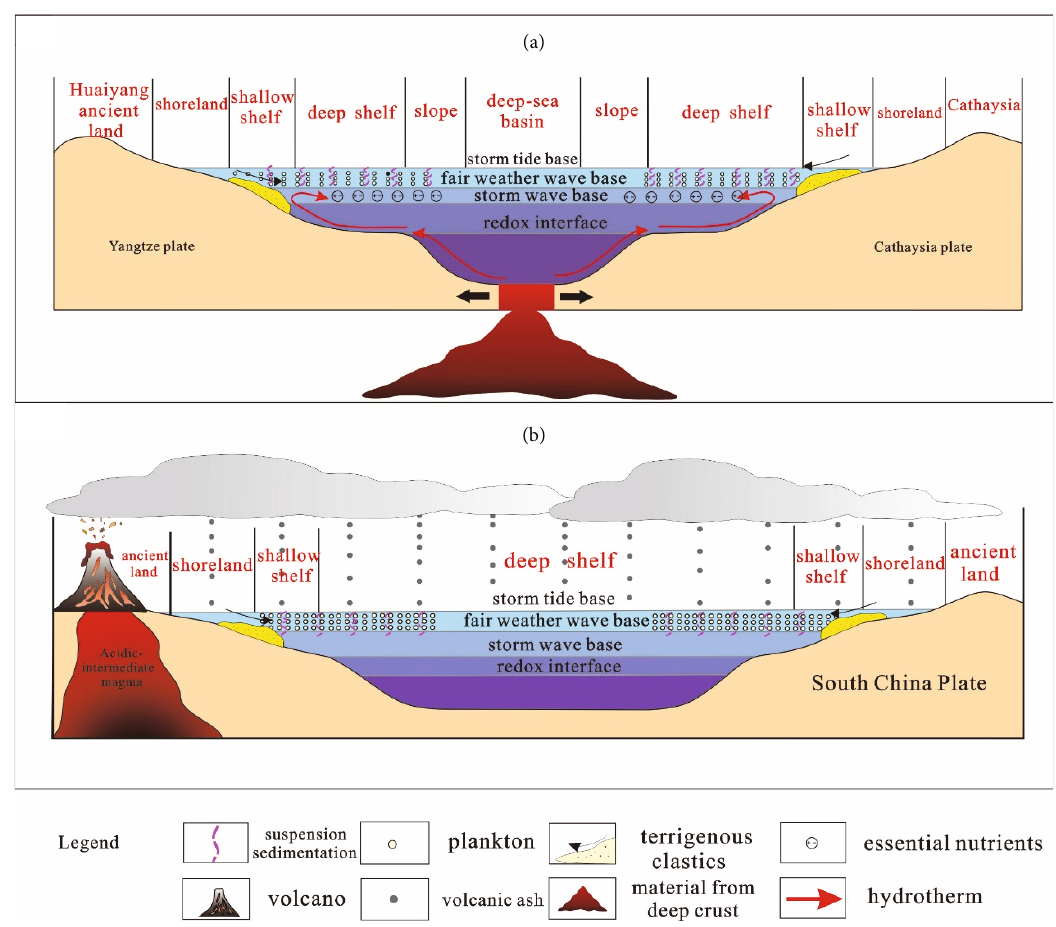
Figure 6: Mechanism of deep geo fl uids ’ in fl uence on the enrichment of sedimentary organic matter. In the south of China in Early Cambrian, deep geo fl uids in the convergence of the Yangtze Plate and the Cathaysian were presented through hydrothermal activities, a ff ecting the bioproductivity on the waterbody ’ s surface and the reducibility at the waterbody ’ s bottom (a). In Late Ordovician-Early Silurian in the same area, deep geo fl uids were presented by volcanic activities, a ff ecting the bioproductivity of the waterbody ’ s surface and the reducibility of the waterbody ’ s bottom